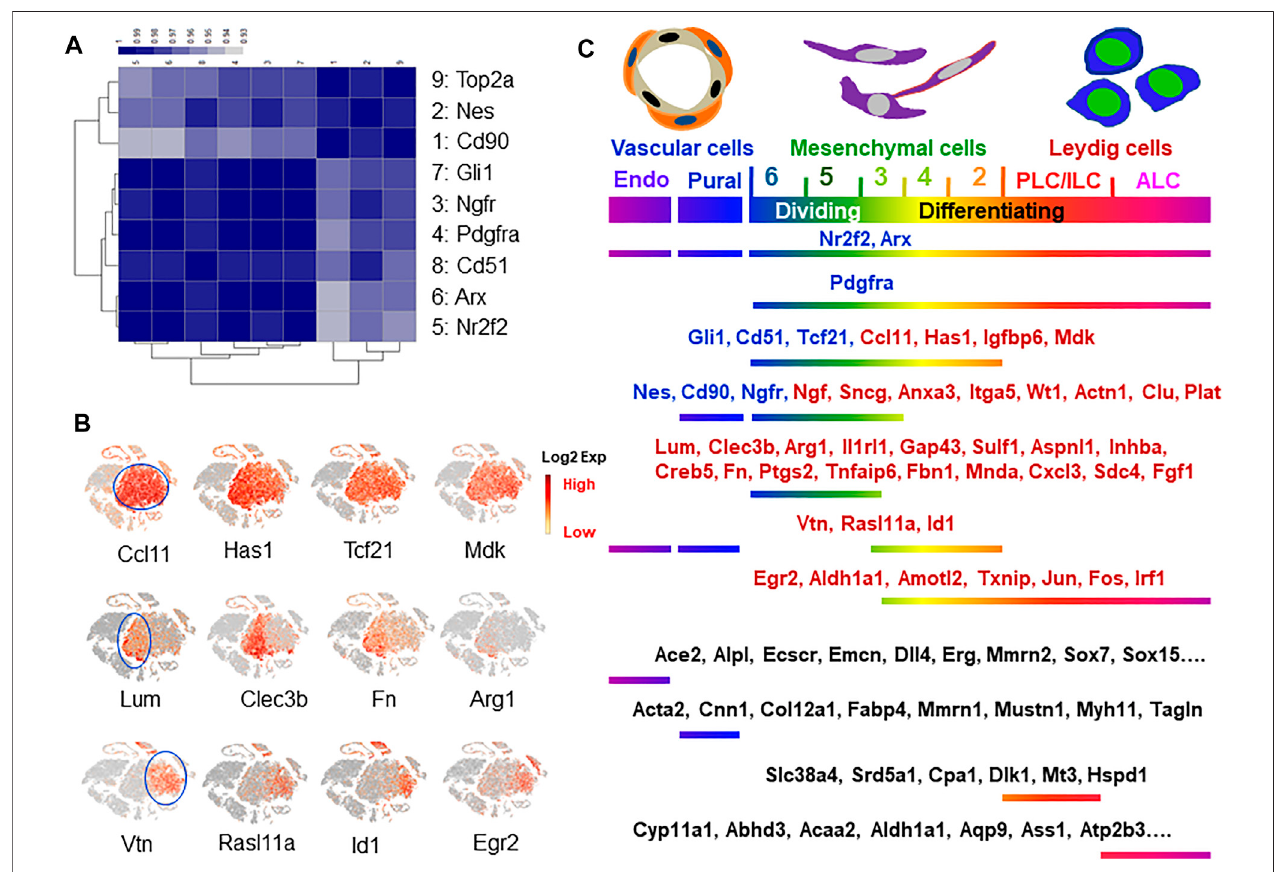
FIGURE 6 | Marker gene identi fi cation and characterization. (A) Correlational coef fi cient among the eight reported SLC markers and dividing marker Top2a. (B) New markergenesidenti fi edwithevenorspeci fi cexpressionsconcentratedoneitherleft-side(clusters4 – 6)orright-side(clusters2 – 3)ofmesenchymalcell “ island ” . (C) Distributions of the reported and newly identi fi ed markers for cells related to Leydig cells.